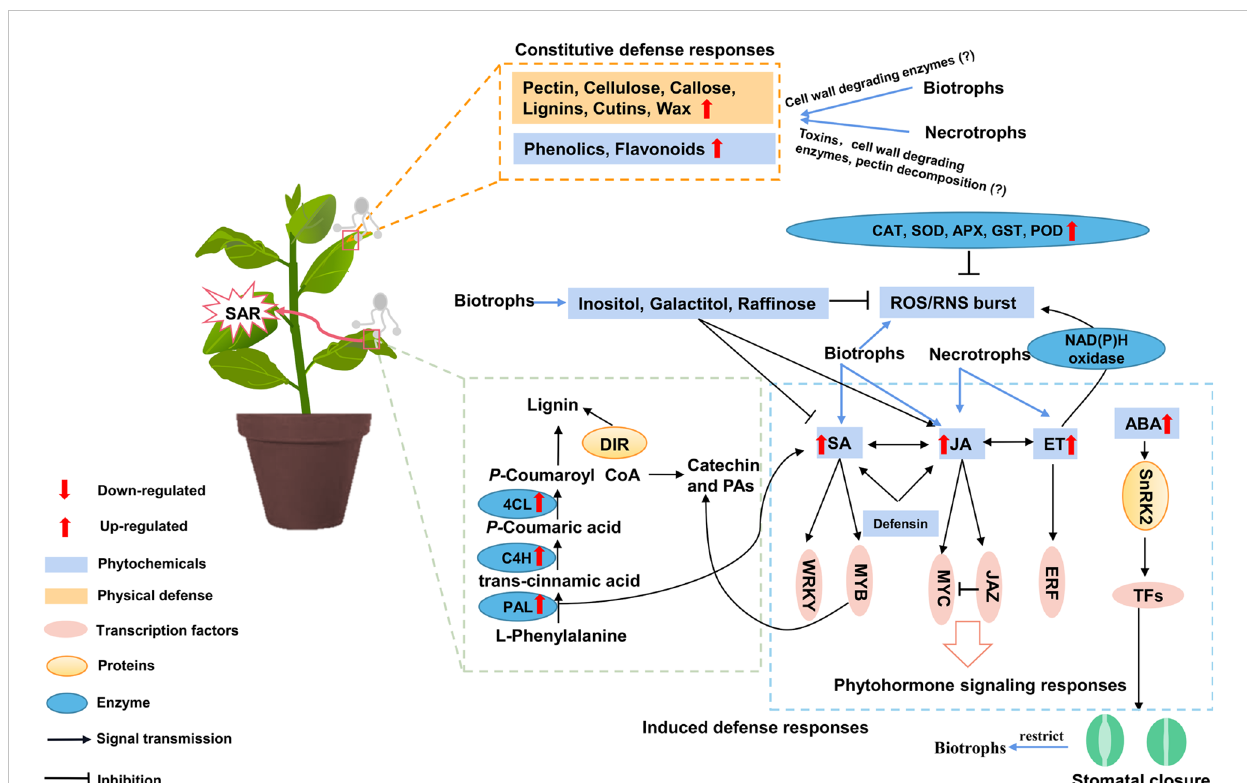
FIGURE 2 A model for the interaction between poplar physical and biochemical defenses. Constitutive defense responses mainly include physical barriers and phytochemicals defenses, when attacked by pathogens. Defense-related metabolites include peroxide, phenolics and phytohormones. The black arrows represent responses caused by biotrophic fungus, grey arrows represent responses caused by necrotrophic fungus, red arrows represent responses caused by all fungus. ABA, abscisic acid; APX, ascorbate peroxidase; C4H, cinnamate 4-hydroxylase; CAT, catalase; 4CL, 4-coumarate- CoA ligase; DIR, dirigent; ET, ethylene; GST, glutathione sulfur transferase; JA, jasmonic acid; JAZ, jasmonate-zim domain; PAL, phenylalanine ammonia lyase; PAs, proanthocyanidins; POD, peroxidase; ROS, reactive oxygen species; SA, salicylic acid; SOD, superoxide dismutase; SAR, systemic acquired